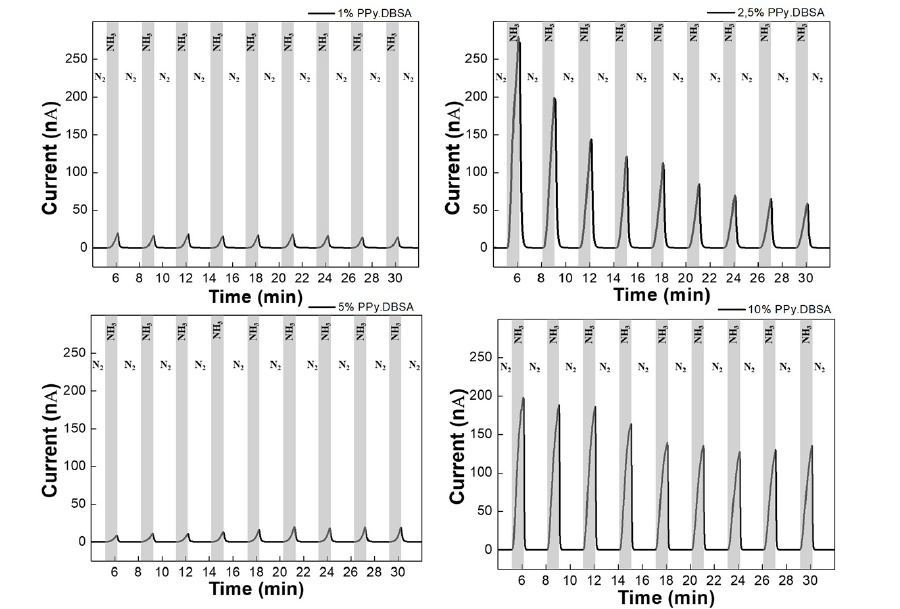
and ammonia (NH 2 3